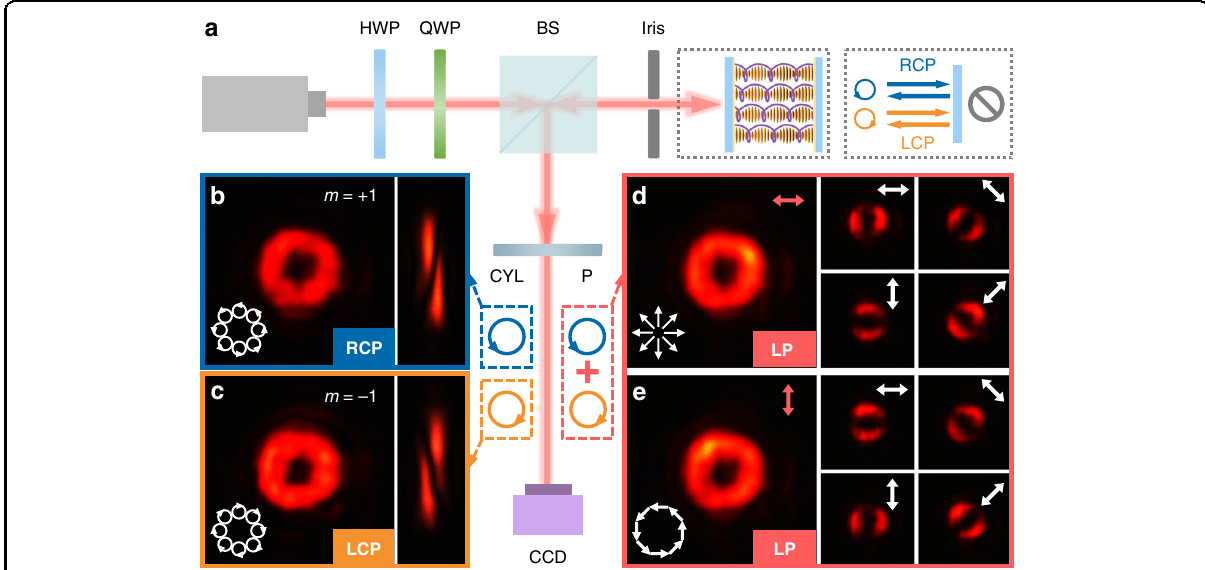
Fig. 3 Generation and detection of OVs from the opposite-chirality-coexisted CLC sample. a Optical set-up. HWP half-wave plate, QWP quarter-wave plate, BS beam splitter, CYL cylindrical lens, P polarizer. Intensity pro fi les and polarization distributions of the re fl ected light at 610 nm under different incident polarization: b RCP (blue circle) and c LCP (orange circle) with corresponding OAM detection result, d horizontal LP and e vertical LP (pink double-ended arrows) with diffraction patterns after transmission through a rotating analyzer (white double-ended